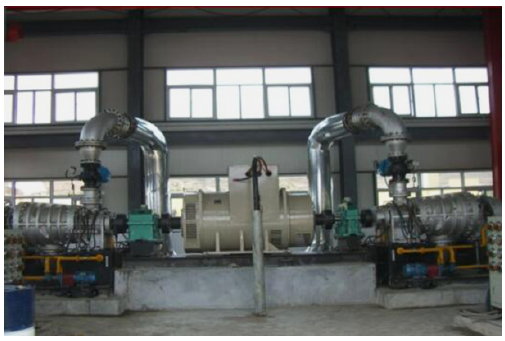
Figure 11. The 1MW screw expander generating unit in YangBaJing geothermal power plant.